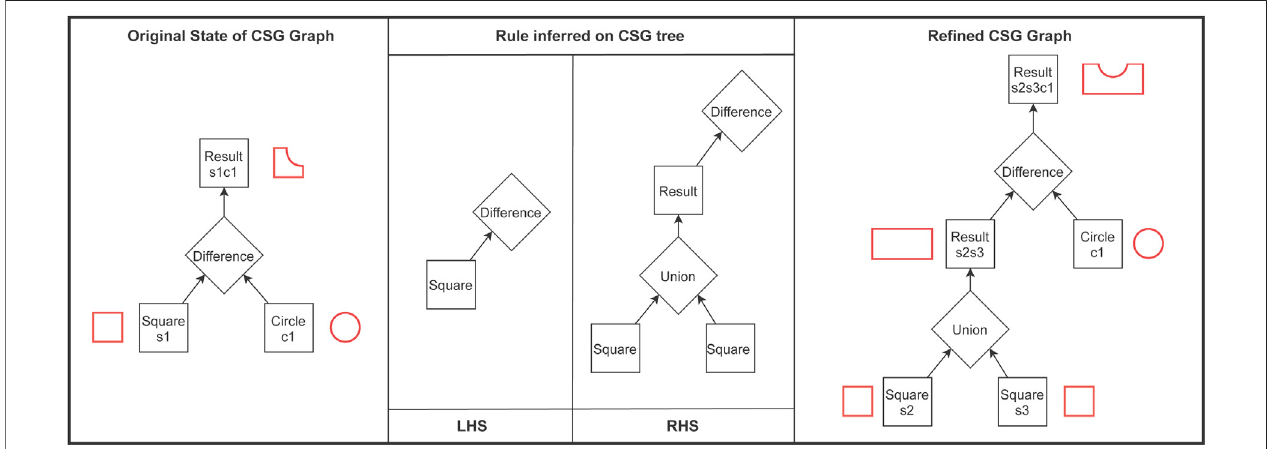
FIGURE 12 | Re fi nement of a CSG tree based on a graph rewriting